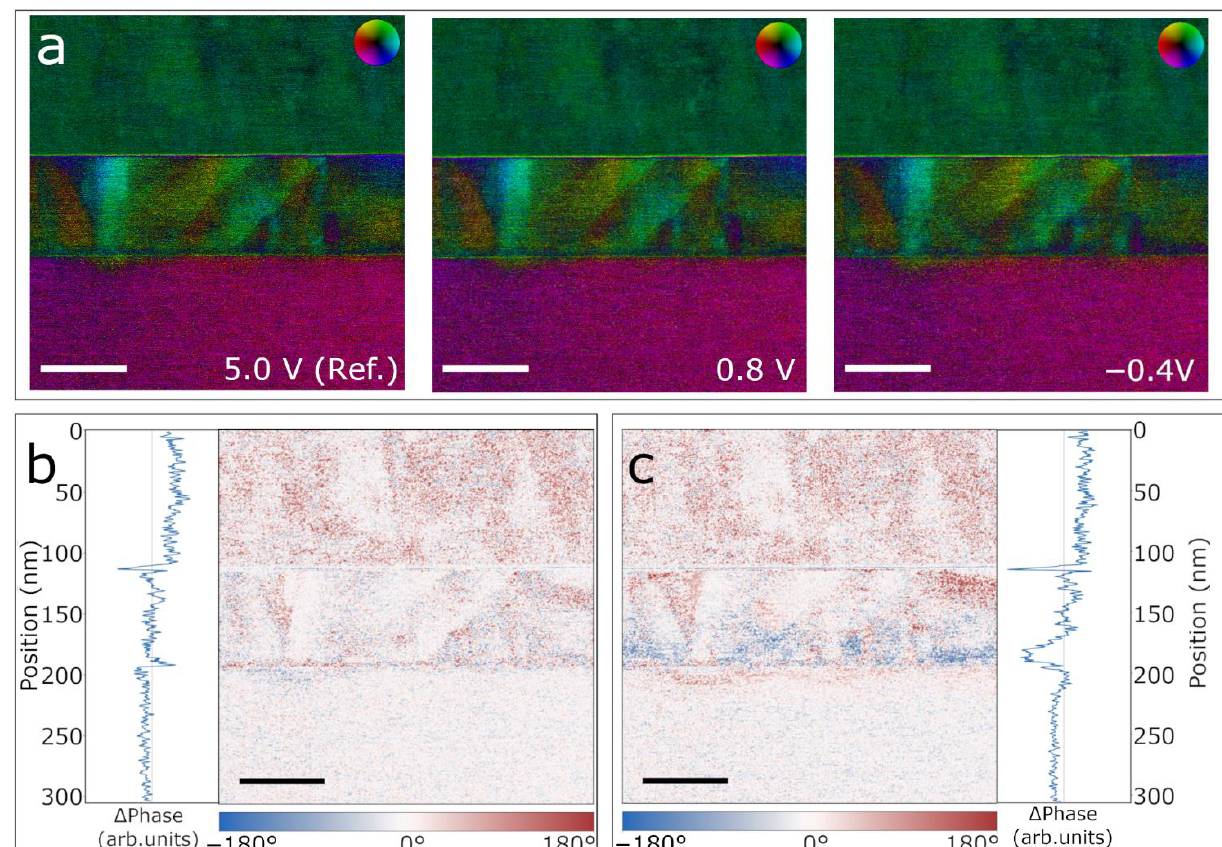
Figure 4. ( a ) DPC vector color plots of the electric field of the PZT film at 5 V (used as a reference), 0.8 V and −0.4 V, where the hue gives the field direction and the saturation is proportional to the vector modulus. Note the difficulty of detecting the changes in the polarization state of the film in the DPC vector plots. ( b ) Phase difference map obtained by subtracting the 5 V and 0.8 V DPC vector plots. ( c ) Phase difference map obtained by subtracting the 5 V and −0.4 V vector plots. The line profiles of the difference maps are extracted over the full image widths. The scale bars are 50 nm.